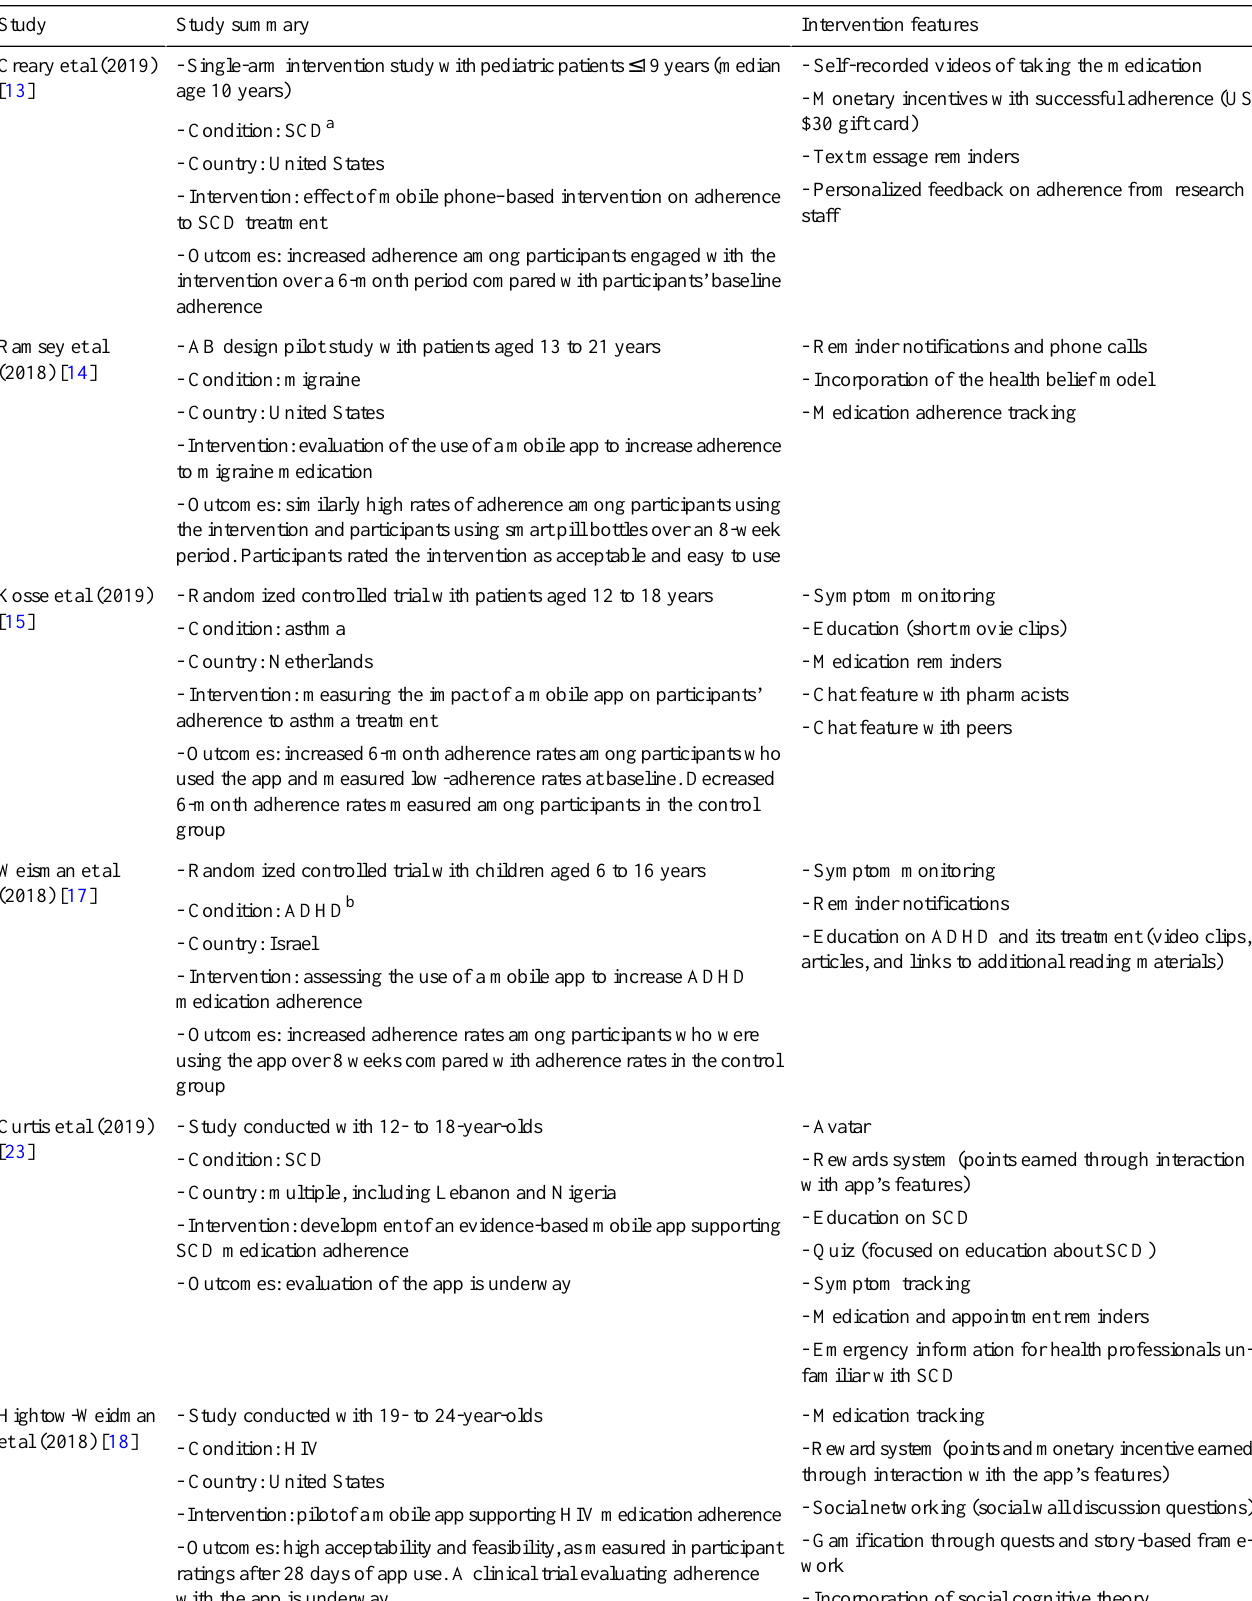
Table 1. Examples of studies that used mobile technology to improve children’s and young people’s treatment adherence.